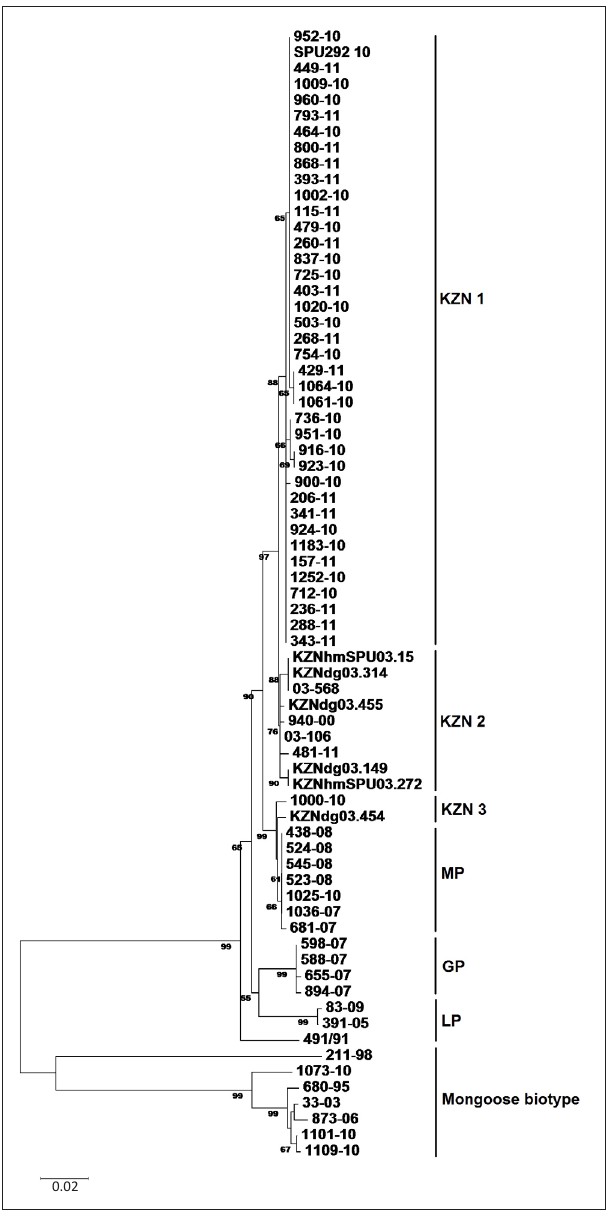
FIGURE 2: Neighbour joining tree showing the genetic relationships of rabies viruses.